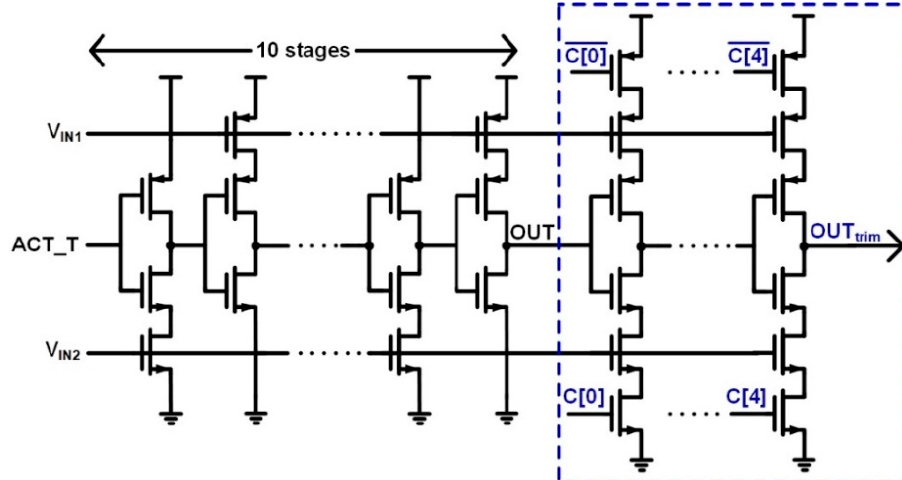
Figure 7. Time-domain comparator with trimming option.